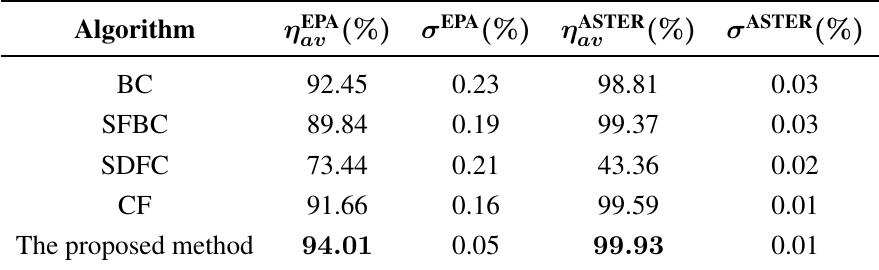
Table 4. Accuracy comparisons of different algorithms with the 2 datasets and SNR = 50 dB.